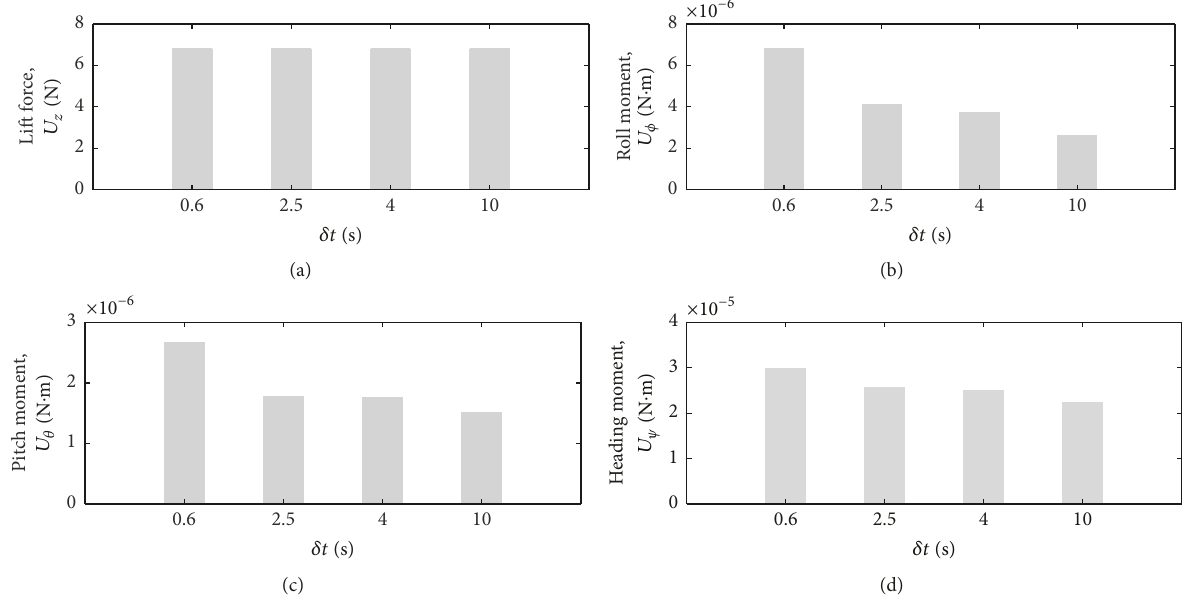
Figure 15: Mean values of (a) lift force and aerodynamical (b) roll and (c) pitch and (d) heading moments,